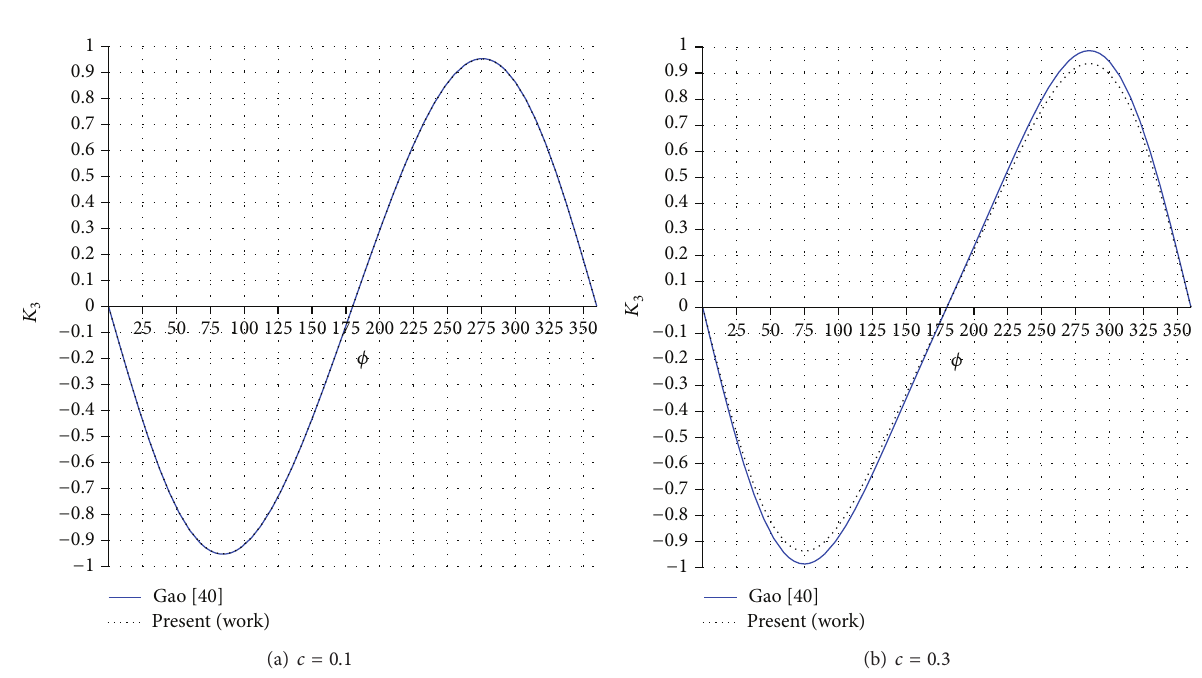
Figure 4: The 𝐾 3 (𝜙) for 𝑓(𝜁) = 𝜁 + 𝑐𝜁 2 at different 𝑐